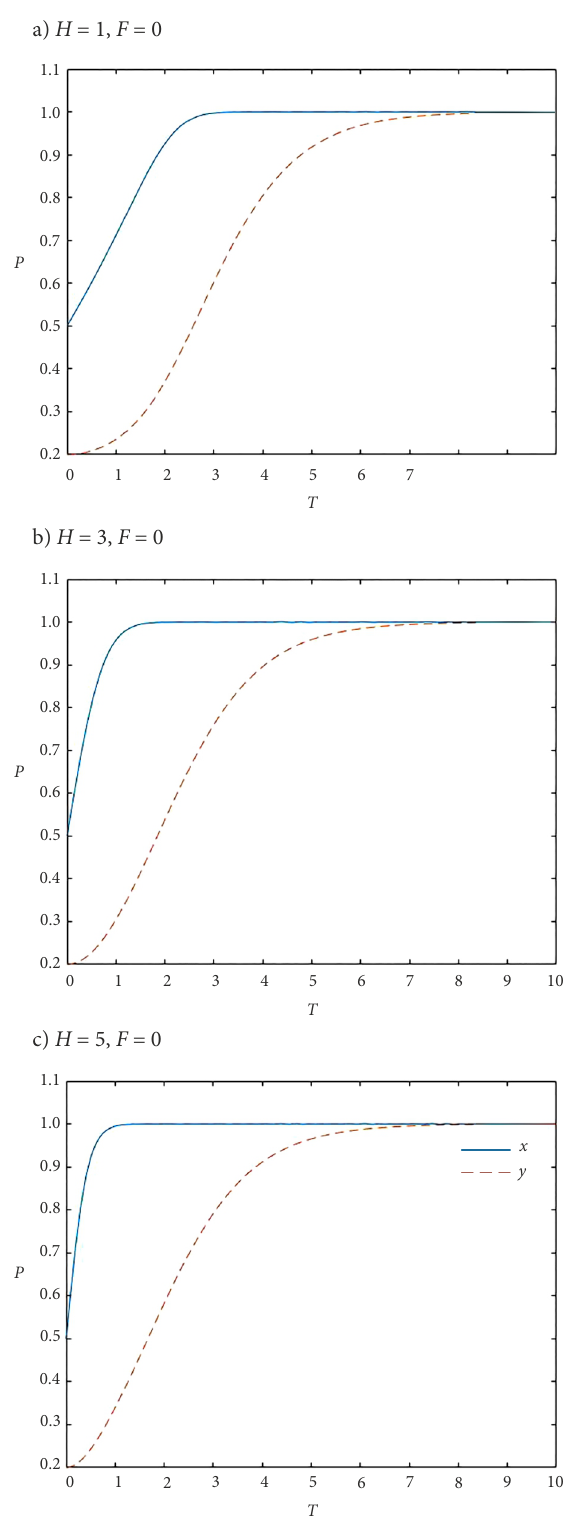
Figure 9. Probability trends for developers and customers with another data set ( H = 1, H = 3, H =